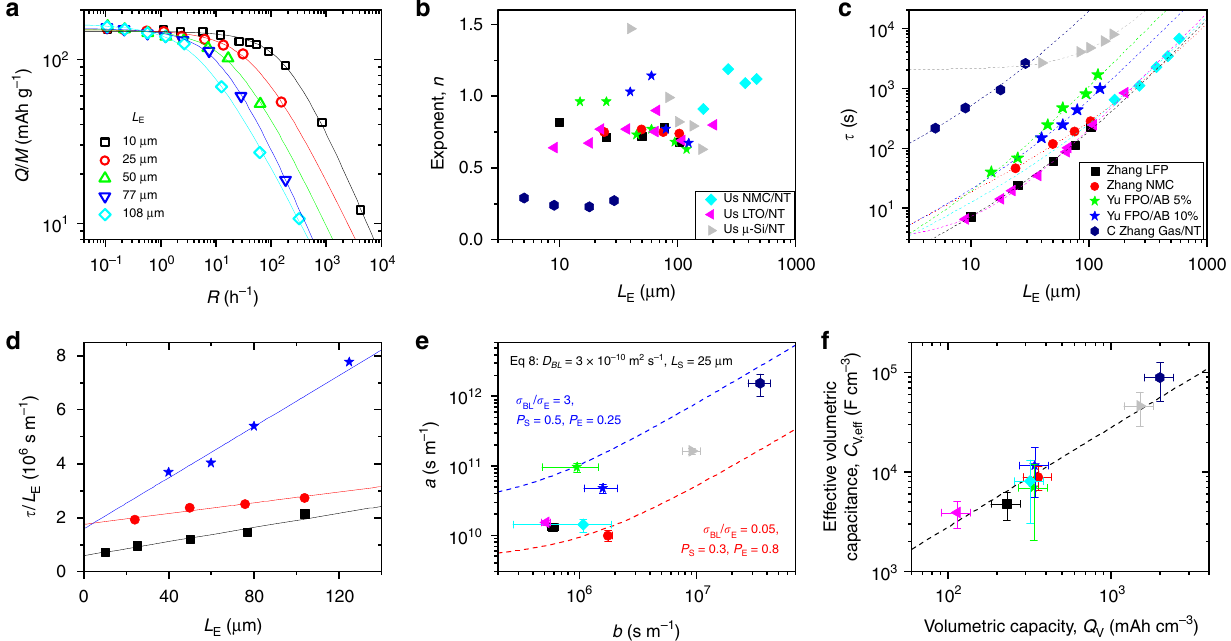
Fig. 4 The effect of varying electrode thickness. a Speci fi c capacity versus rate data for LiFePO 4 -based lithium ion cathodes of different thicknesses 17 . The solid lines are fi ts to Eq. (2) . b and c Exponent ( b ) and characteristic time ( c ) plotted versus electrode thickness for eight data sets including three measured by us and fi ve from the literature 7,16,17 . The legends in b and c both apply to panels b – f . The dashed lines in c are fi ts to the polynomial given in Eq. (6b) . d Plots of τ = L versus L for a subset of the curves in ( c ), showing the c -terms to be negligible (true for all data in ( c ) except the μ -Si/NT and E E NMC/NT data sets). e a parameter plotted versus b parameter (see Eq. (6a), (6b)) for the data in c . The lines are plots of Eq. (8) using the parameters given in the panel and represent limiting cases. f Effective volumetric capacitance, estimated from the b parameters, plotted versus the volumetric capacity, Q ¼ ρ Q . The dashed line is an empirical curve which allows C V,eff (F cm − 3 ) to be estimated from Q V (mAh cm − 3 ): C V M E this fi gure are fi tting errors combined with measurement